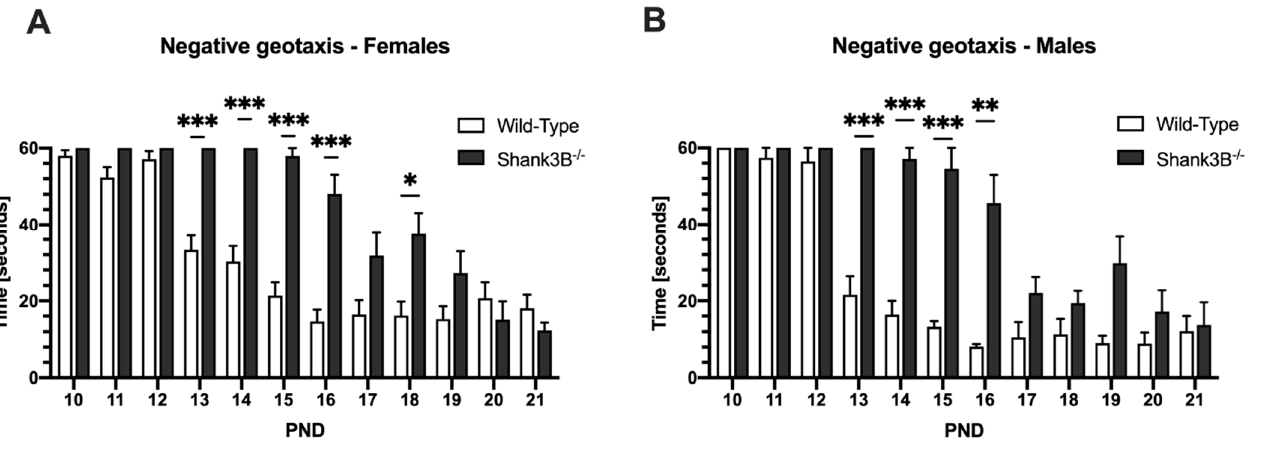
Figure 5. Motor skills . ( A ) Negative geotaxis in females. ( B ) Negative geotaxis in males ( C , D ) Gait and walking initiation, respectively. PND = postnatal day; * denotes p < 0.05, ** denotes p < 0.01 and *** denotes p < 0.001. Data are shown as mean + SEM. Shank3B − / − : ♀ n = 13, ♂ n = 10; Wild-Types: ♀ n = 29, ♂ n = 15. 4. Discussion Our experiment showed that Shank3B − / − mice were delayed in eye opening and audi- tory startle compared to their wild-type littermates. Also, negative geotaxis was impaired between PND 13–16, regardless the gender. Nevertheless, these represent only a few of the measured landmarks, reflexes, or motor skills during early postnatal development of our experiment. According to our knowledge, this is the first thorough examination of early neurodevelopment of potential in an animal ASD model. Interestingly, Shank3B − / − and wild-type mice did not differ in body weight as previ- ously observed by Peça and colleagues, who did not record any discrepancies in body weight of Shank3 -deficient mice, either [20]. On the other hand, in other rodent models